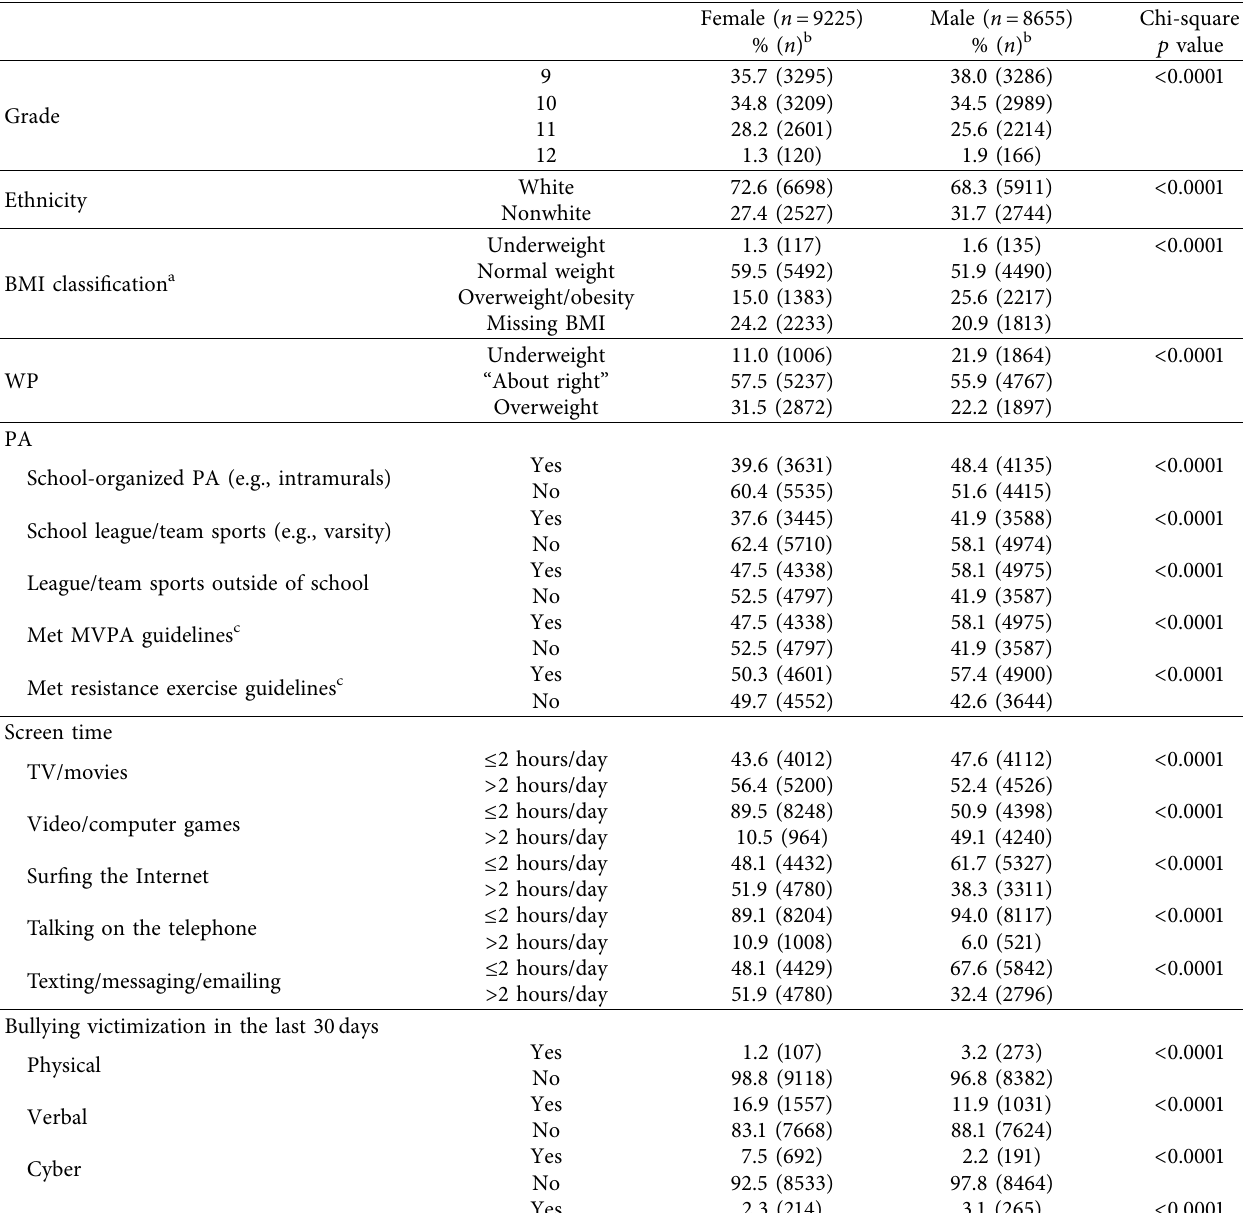
Table 1: Year 3 (2014/2015) descriptive statistics among grade 9–12 students with 2-year linked data for Year 3 (2014/2015) and Year 4 (2015/2016) in the COMPASS